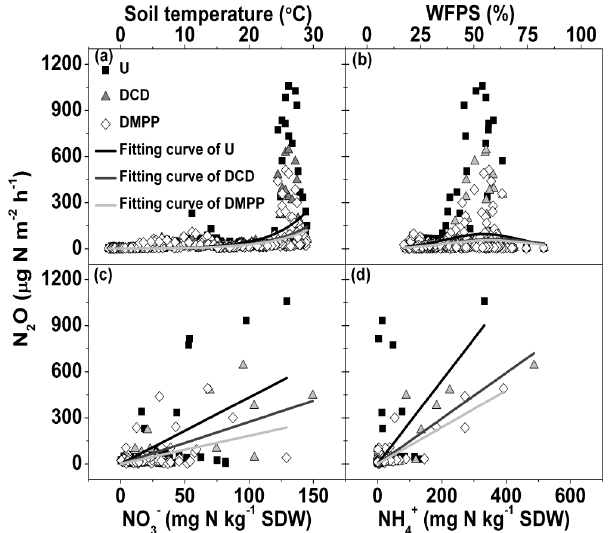
Fig. 4. Relationship between daily averaged soil temperatures, water-filled pore space (WFPS), nitrate (NO − ) content and daily means of N 2 O flux. SDW: soil dry weight. (NH + 4 U, DCD and DMPP: urea, urea + DCD and urea + DMPP treat- ments.